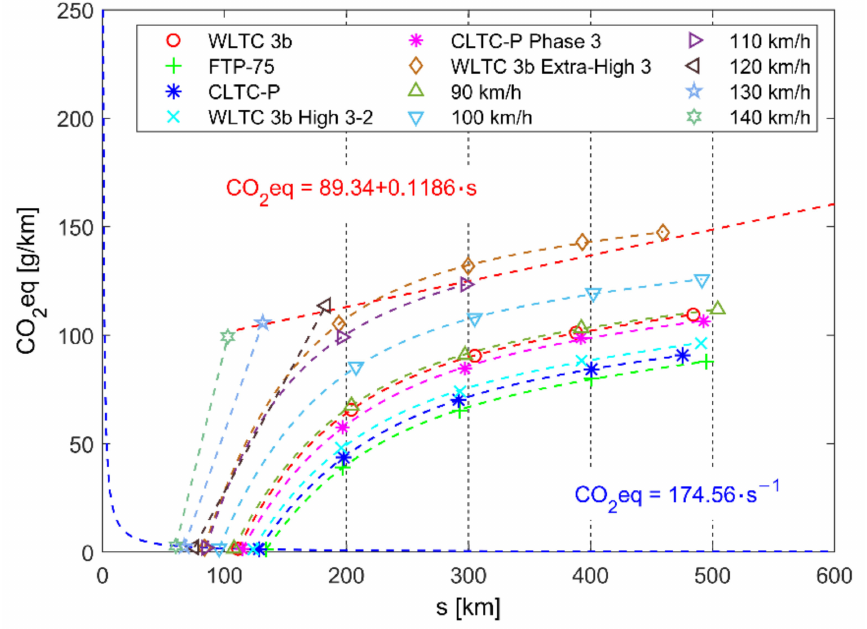
Figure A9. Combined CO 2 eq emission, due to EREV operation and electricity production (Sweden), in various driving conditions. Note that the blue approximation line (BEV mode) and the red approximation line (maximal range) are obtained for constant speed driving results from the range of 90–140 km/h. Vehicle mass is equal to 1800